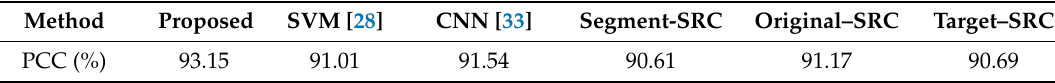
Table 6. Performances of different methods in terms of configuration variance.